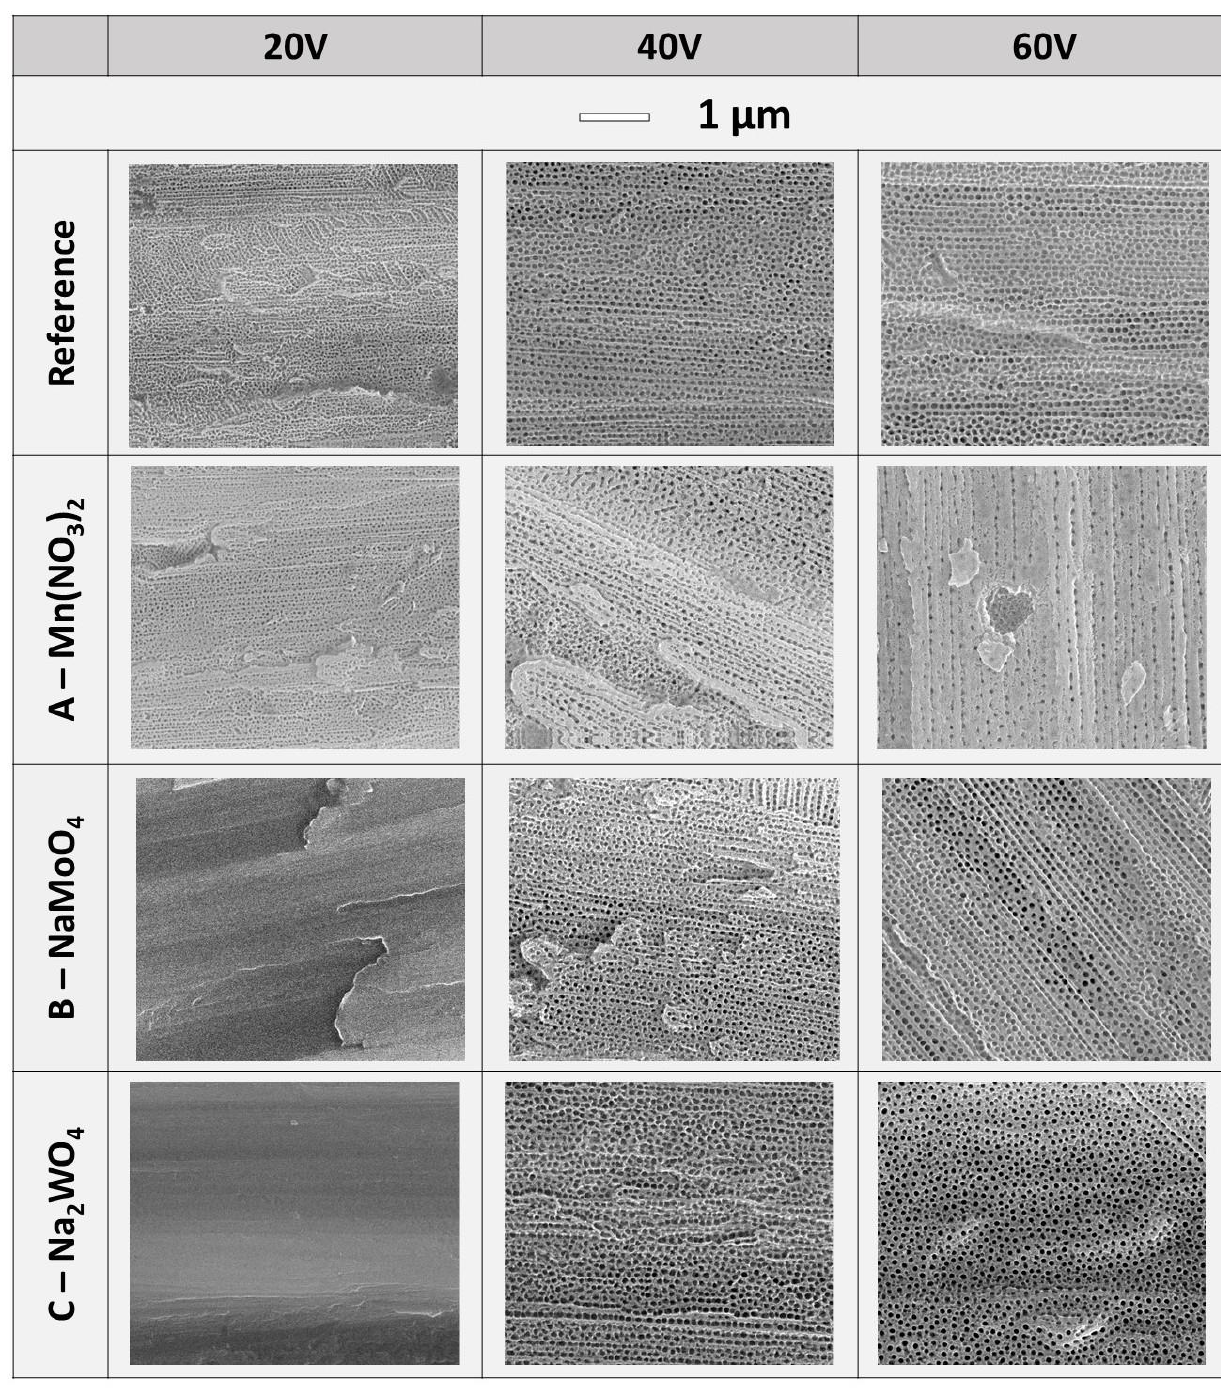
Figure 2. Morphology of anodic titanium oxide depending on the used electrolyte and the applied voltage.